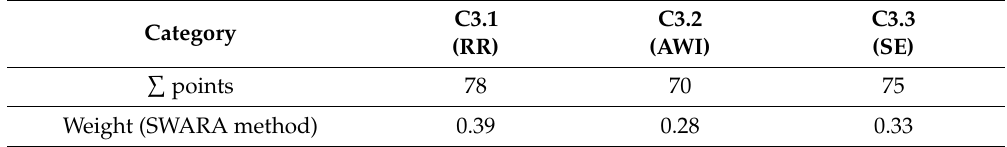
Table 23. Determination of weights of water governance